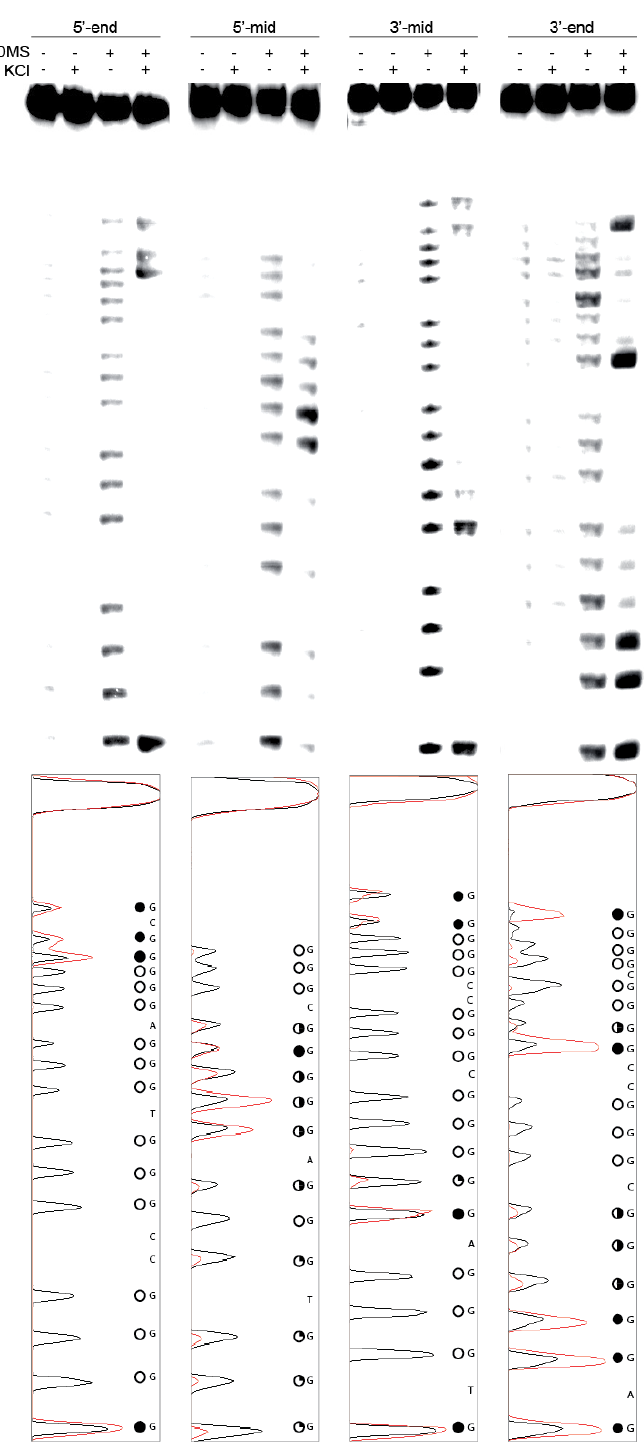
Figure 5. DMS footprinting of ADAM-15 truncated sequences 5'-end, 5'-mid, 3'-mid, 3'-end in the absence and presence of 140 mM KCl demonstrated the guanines involved in predominating G4 species. Histograms of each cleavage pattern are shown below in the absence (black line) and presence (red line) of KCl were used to determine the protection pattern indicated by the circles to the right of the figure: filled circle = hyper-cleaved, half-filled circle = partial protection indicative of protection within a subset of the equilibrating G4s, open circle = full protection indicative of incorporation in the majority of equilibrating G4